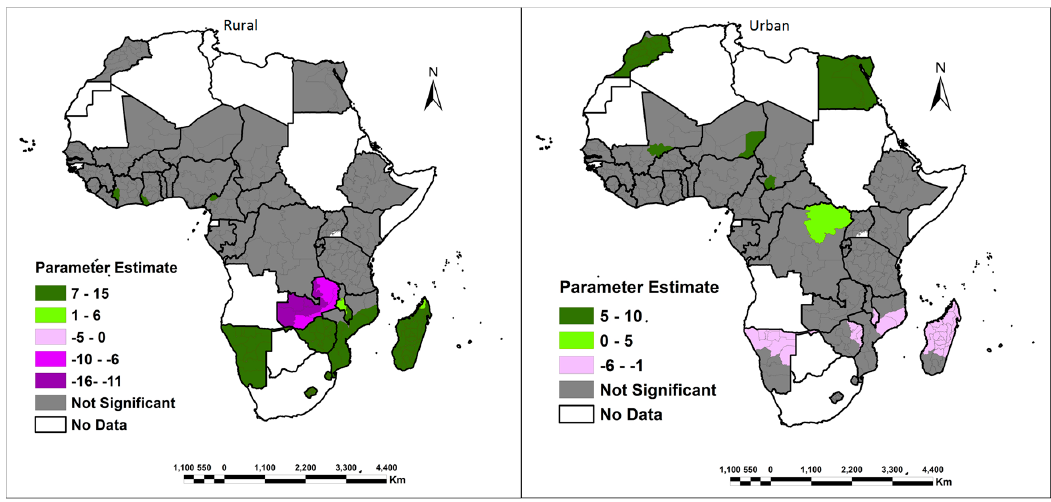
Figure 15. Spatial distribution and significance of place of residence on women’s access to own land.